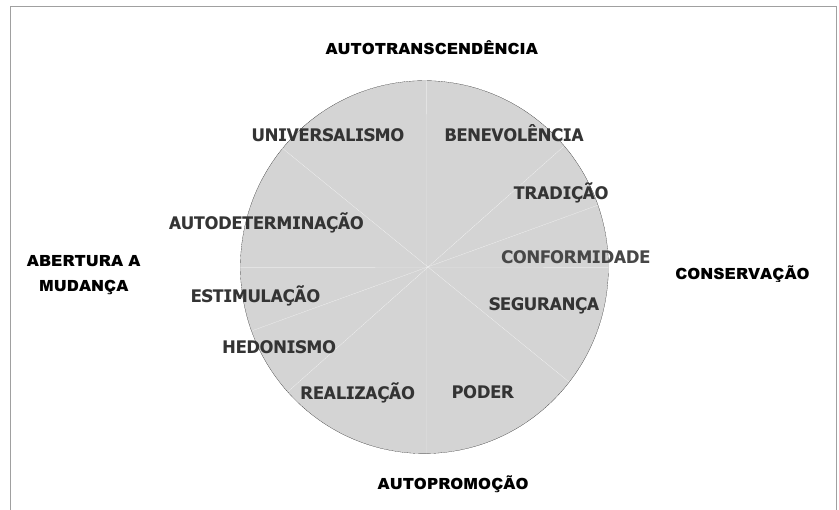
Figura 1. Estrutura teórica das relações entre tipos